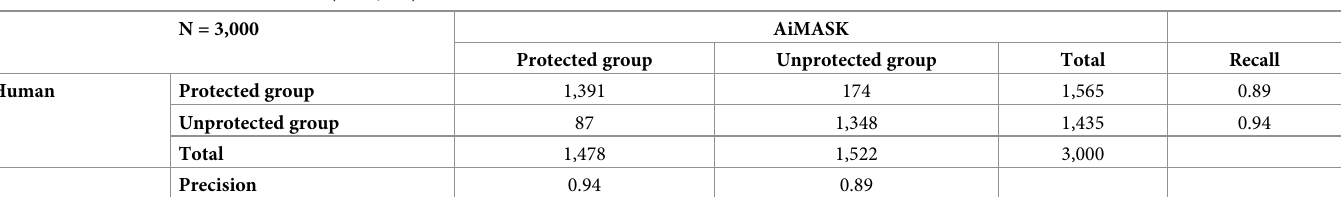
Table 2. External validation of AiMASK (n = 3,000).